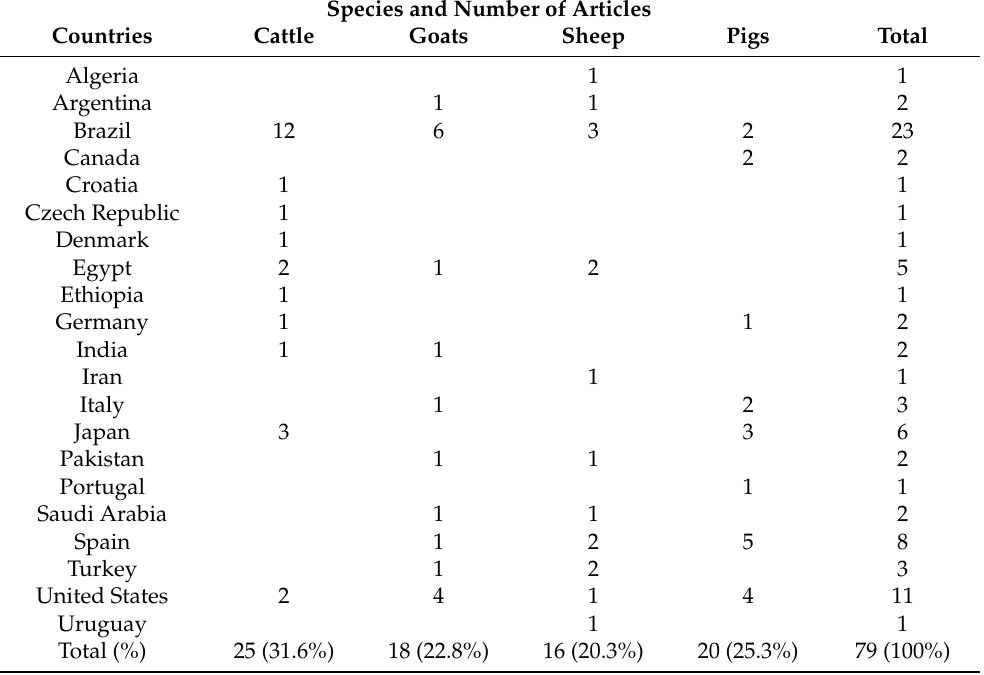
Table 1. Number of studies, according to the country where they were carried out and the species affected by